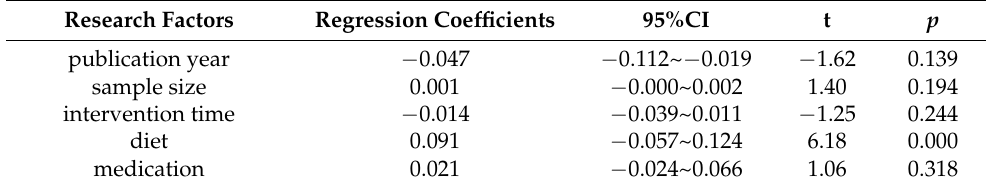
Table 4. Meta regression analysis of heterogeneous factors of LDL.